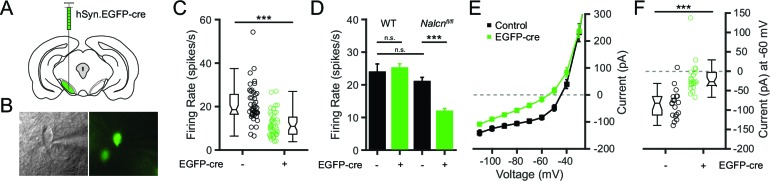
Conditional knockout of NALCN in SNr neurons slows spontaneous firing.(A) Schematic depicting unilateral injections of the adeno-associated virus containing the hSyn-EGFP-cre construct. (B) Bright field (left) and fluorescent (right) images of an example EGFP-cre positive SNr neuron from which recordings were obtained. (C) Firing rates of EGFP-cre negative (21.0 ± 1.3 spikes/s; n = 45) versus positive (11.9 ± 0.9 spikes/s; n = 43) neurons from Nalcnfl/fl transgenic mice (unpaired t-test; ***p<0.0001). Box plot notches indicate the 95% confidence intervals. (D) Mean firing rate of EGFP-cre negative (23.9 ± 2.5 spikes/s; n = 27) and positive (25.2 ± 1.3 spikes/s; n = 39) neurons from WT mice (unpaired t-test; P = 0.62), and EGFP-cre negative and positive neurons from Nalcnfl/fl mice. n.s.p>0.05; ***p<0.001; one-way ANOVA with Bonferroni post hoc correction. (E) Steady-state I-V recordings from EGFP-cre negative (black symbols; n = 19) and positive (green; n = 21) neurons. (F) Steady-state current (pA) at -60 mV from EGFP-cre negative (n = 19) and positive (n = 21) neurons (unpaired t-test; ***p<0.0001).